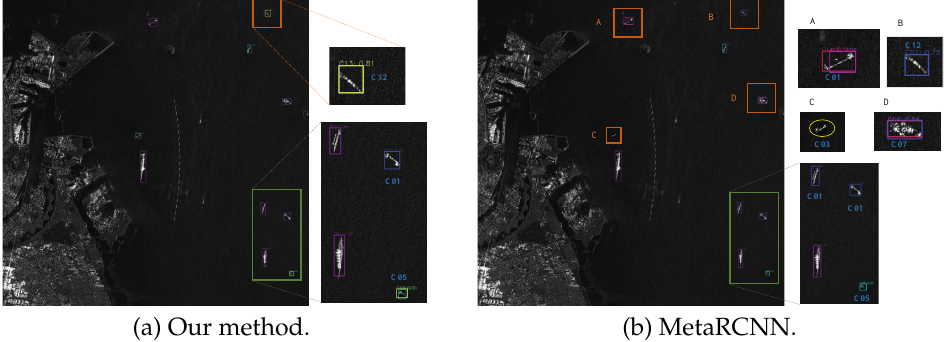
Figure 10. Comparison of detection results on large-scale SAR image. The orange and green area are shown enlarged on the right side of the sub-image. ( a ) Detection results of our method. ( b ) Detection results of